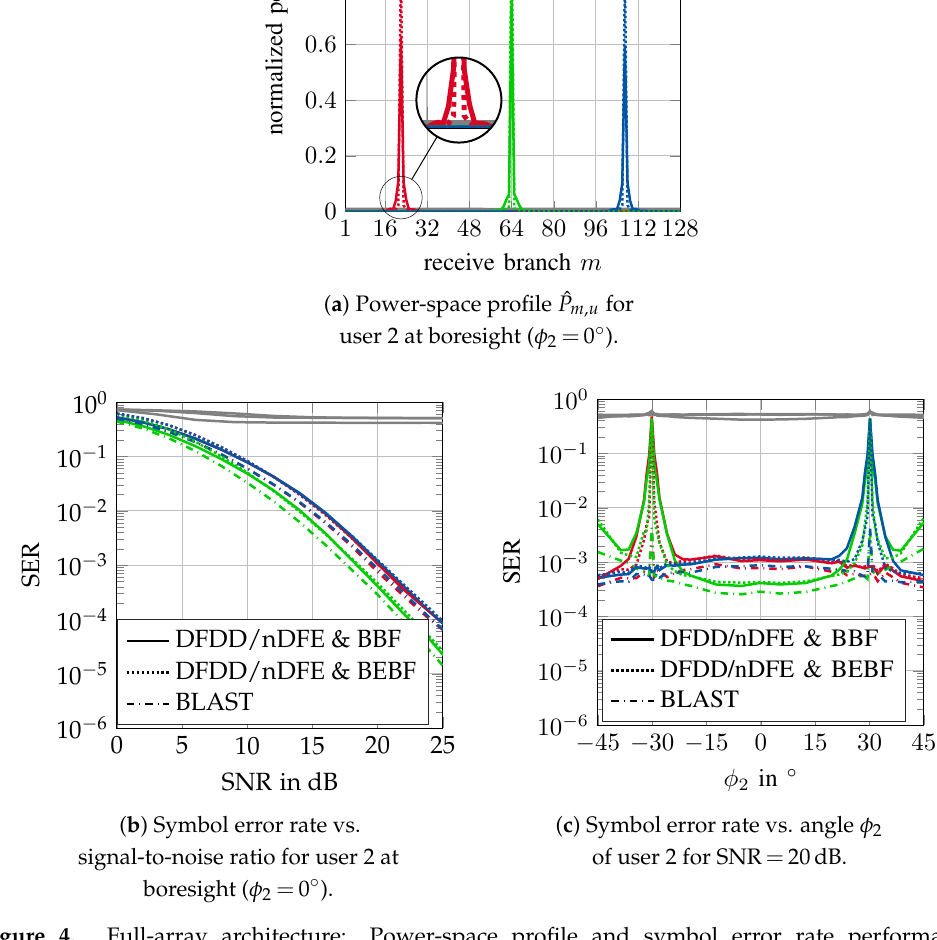
Figure 4. Full-array architecture: Power-space profile and symbol error rate performance. Colors correspond to users: user 1 ( ), user 2 ( ), user 3 ( ). Gray plots ( ) represent results without digital beamspace preprocessing for each